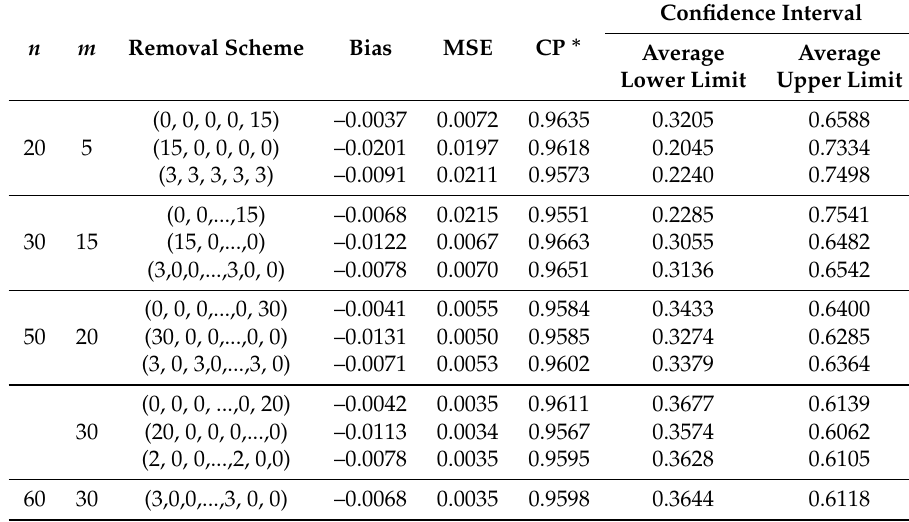
Estimation results of δ s , k using the parametric percentile bootstrap method for